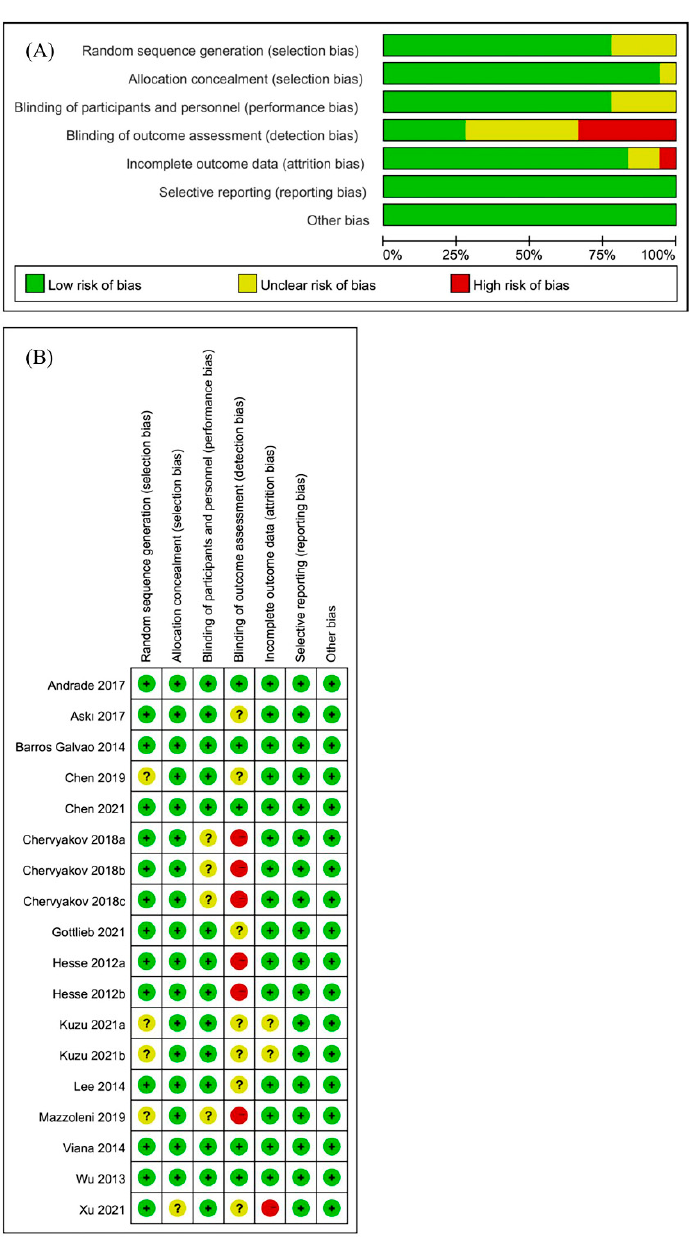
Figure 4. Risk of bias in the systematic review. ( A ) Risk of bias graph: review of the authors’ judgments about each risk of bias item, presented as percentages across all included studies. ( B ) Risk of bias summary: review of authors’ judgments about each risk of bias item for each included study.